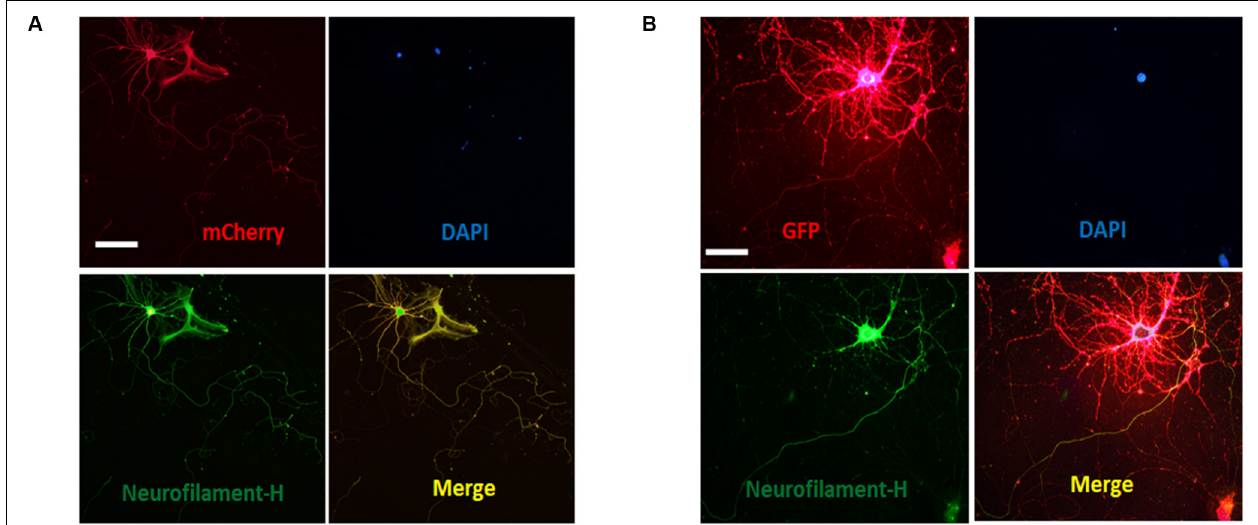
FIGURE 5 | Distribution of ASICs on axons of cultured mature hippocampal neurons. (A) Co-staining of hippocampal neurons with anti-mCherry (ASIC1a, red) and Neurofilament-H (green) antibodies. Overlay of them indicates that ASIC1a is expressed on the axons. Scale bar, 100 µ m. (B) co-staining of neurons with anti-GFP (ASIC2a, red) and Neurofilament-H (green) antibodies. Overlay of them indicates that ASIC2a is expressed on the axons. Scale bar, 50 µ m.